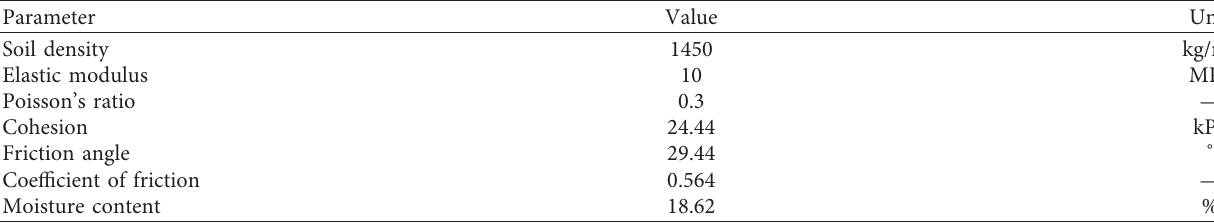
Figure 4: Shear test process of root-soil composites: (a) perforated cloth root of the direct shear specimen; (b) finished sample. (c) direct shear devices; (d) specimens after shear failure. Table 2: Soil parameters in the numerical simulation.